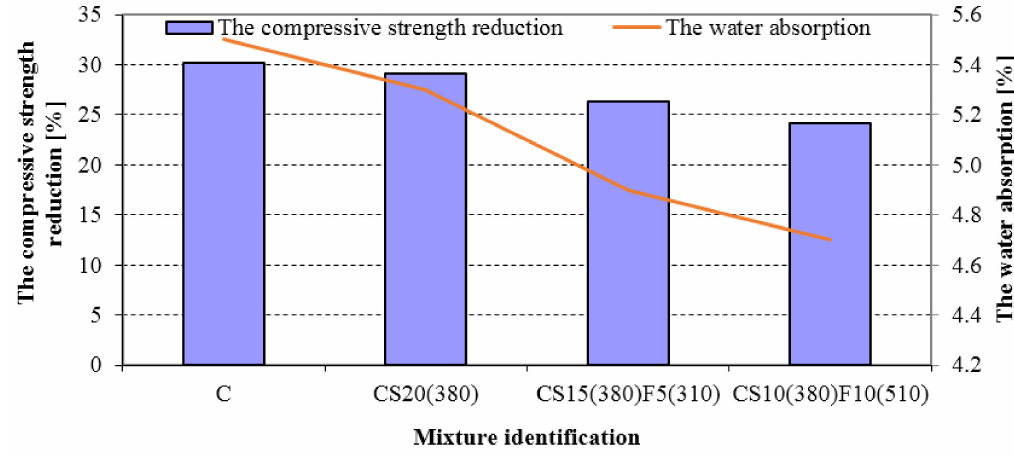
Figure 7. The water absorption and compressive strength reduction of concretes after 100 freezing/thawing